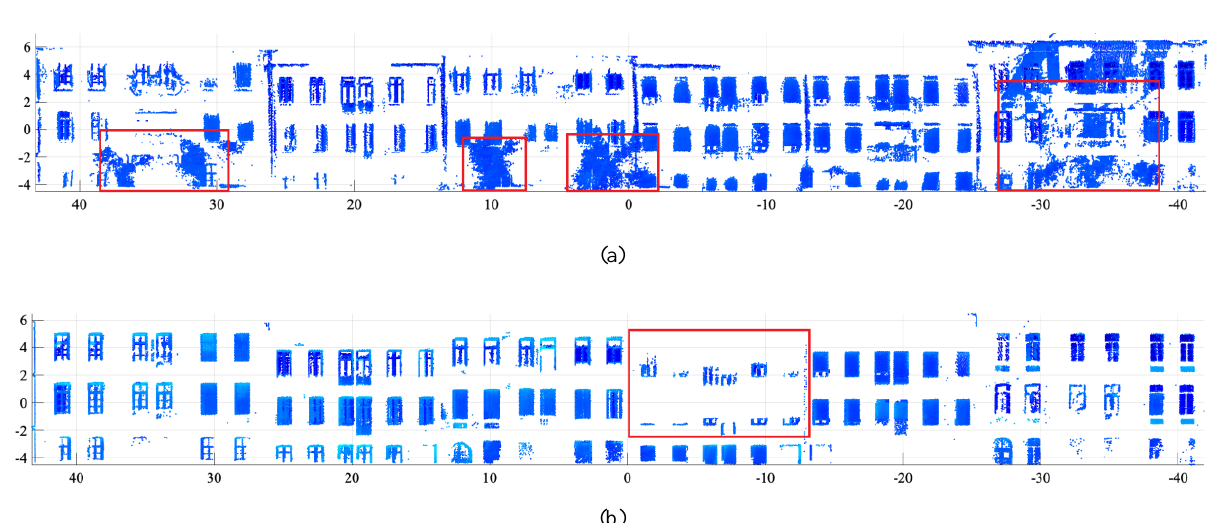
Figure 3: Global analysis – extraction of windows: (a) based on thermal attributes; (b) based on the location of points regarding the façade plane